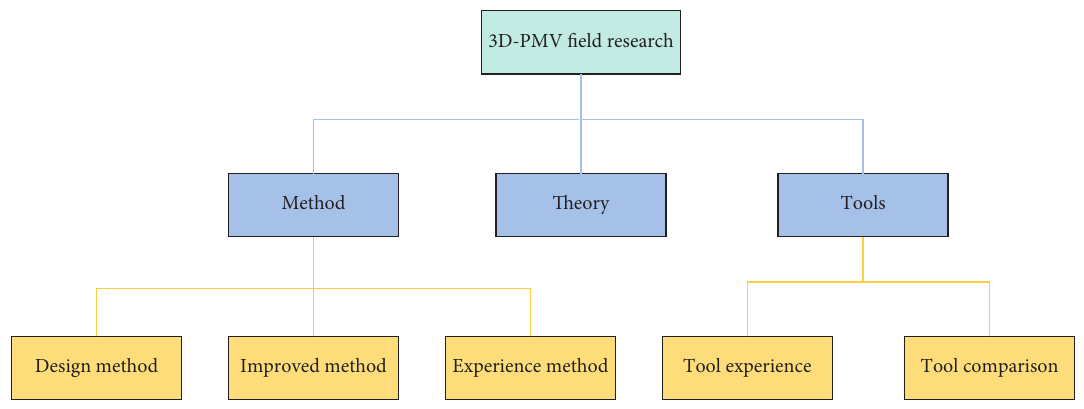
Figure 3: Classification of 3D-PMV research